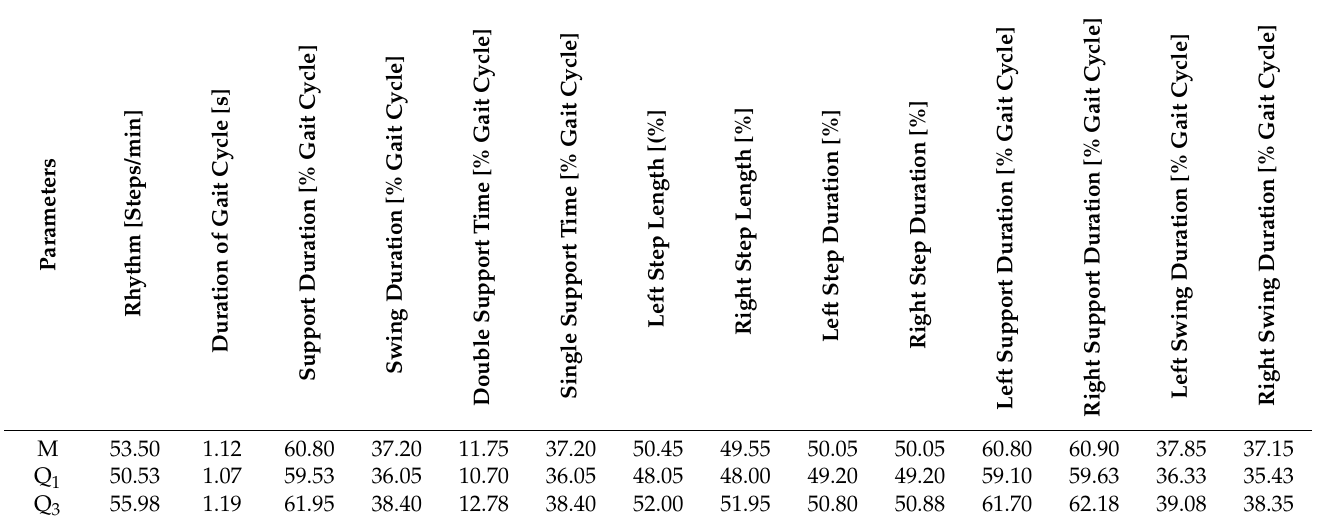
Table 1. Fundamental statistics of measurement values of gait parameters